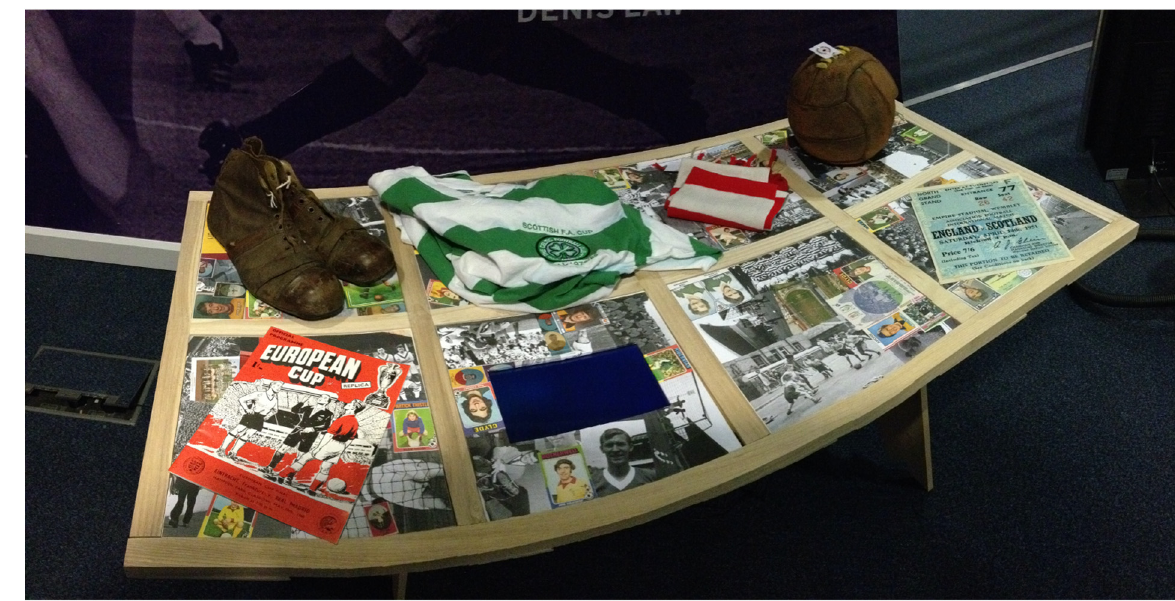
Figure 2. Interactive Scottish football table.